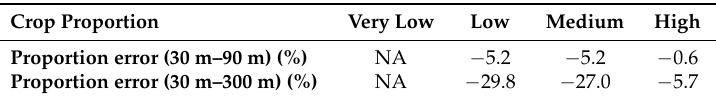
Table 4. Proportion error for two cases (initial resolution = 30-m; and lower resolution = 90-m or 300-m) within the four crop proportion